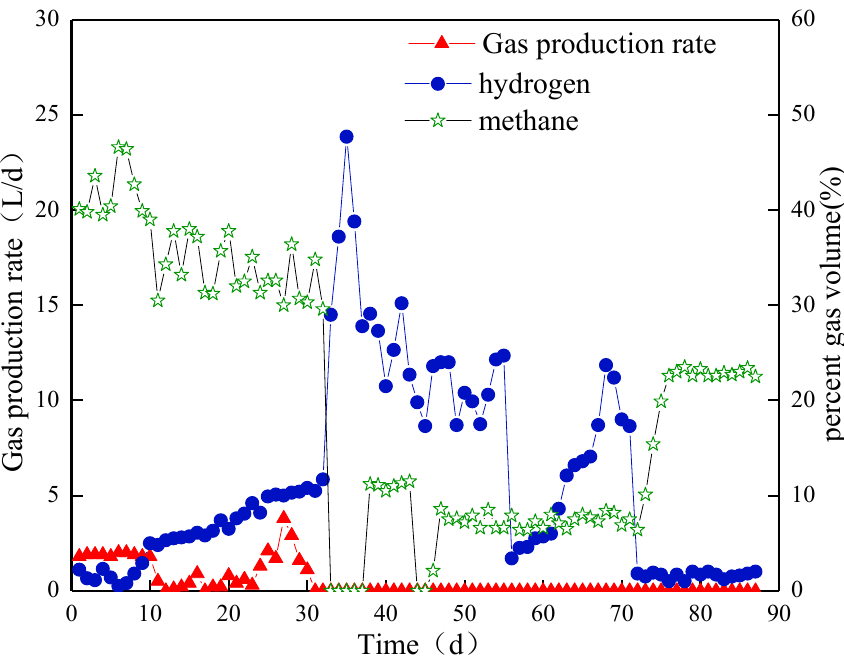
Figure 7. Biogas yield and content in Compartment IV.